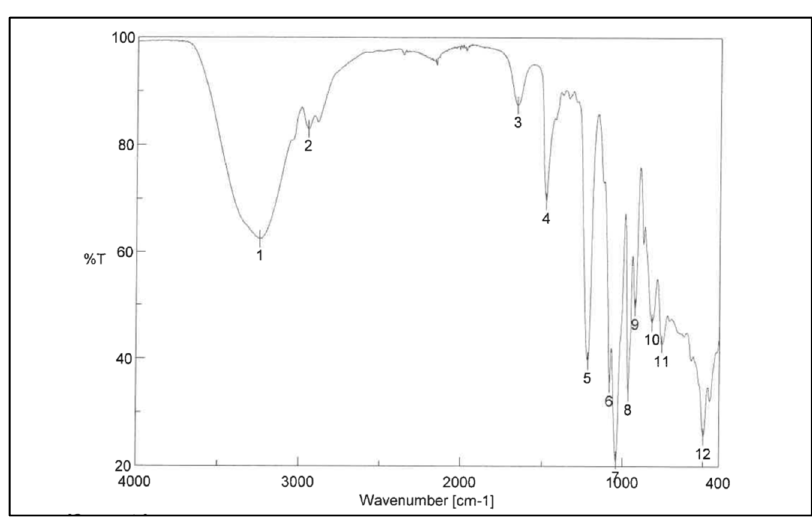
Figure 3. IR spectrum of choline